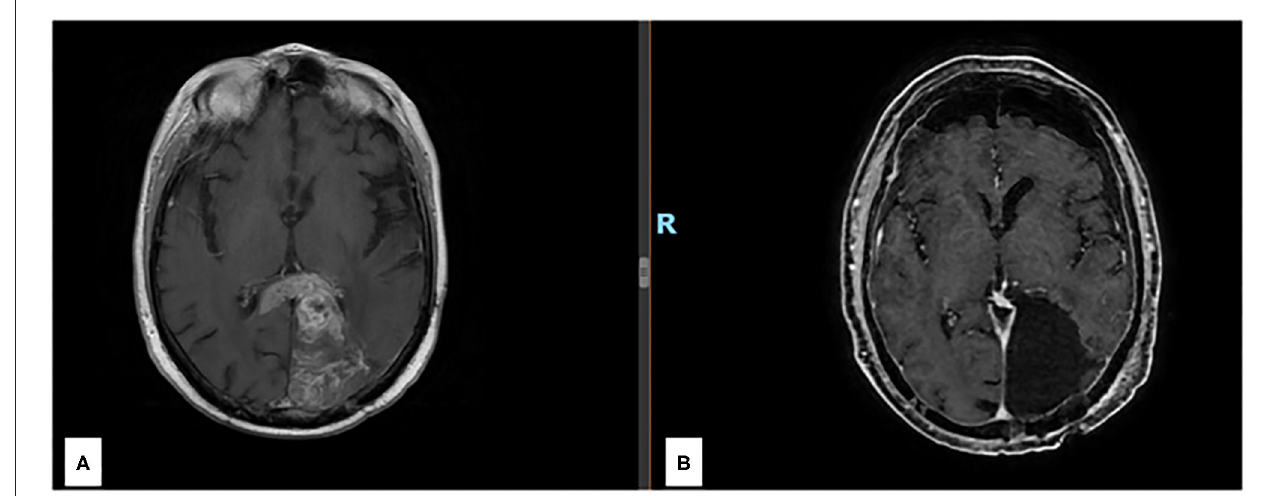
FIGURE 1 | (A) Preoperative axial section of a T1w MRI after gadolinium injection revealing a left parieto-occipital recurrent lesion with infiltration of the splenium of the corpus callosum. (B) Postoperative axial section of a T1w MRI after gadolinium injection revealing the complete resection of the enhancing nodule.